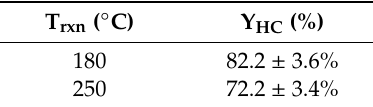
Table 7. Hydrochar yield for the two investigated